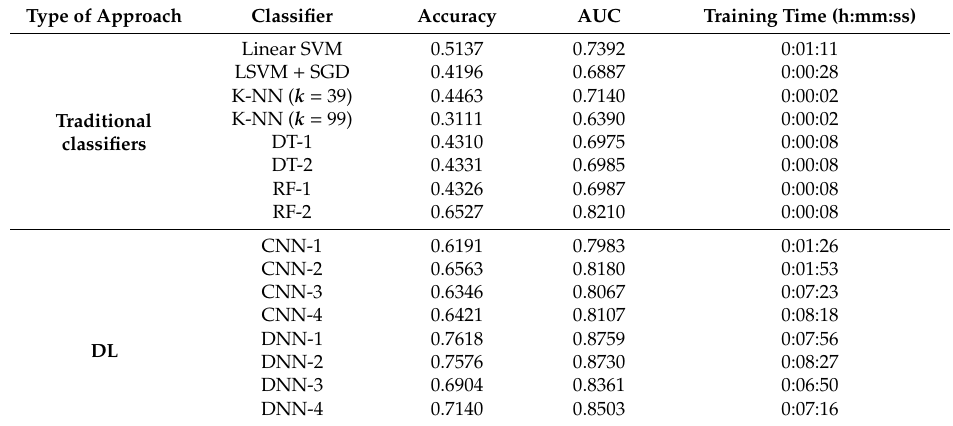
Table 4. Accuracy and area under the curve (AUC) values with test dataset and training time obtained by di ff erent